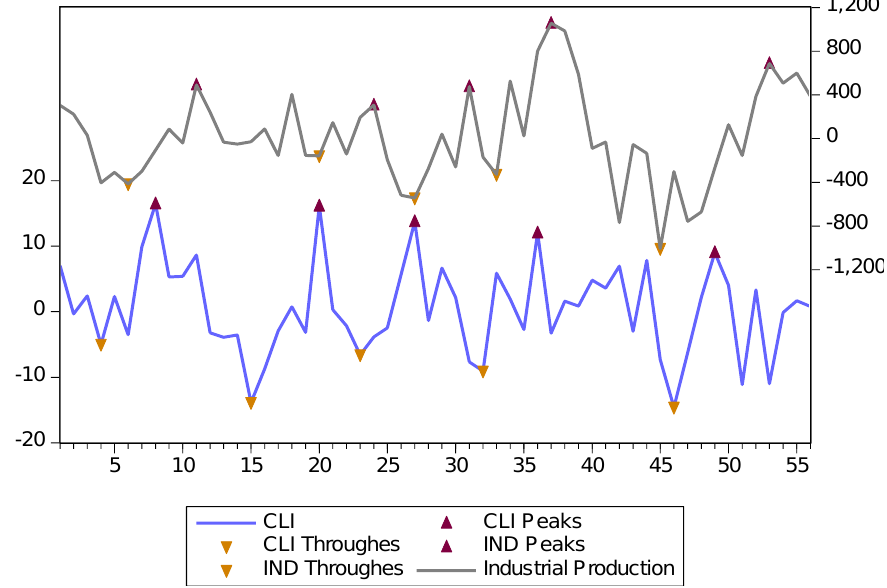
Figure 8. Comparing the turning points of CLI with reference series